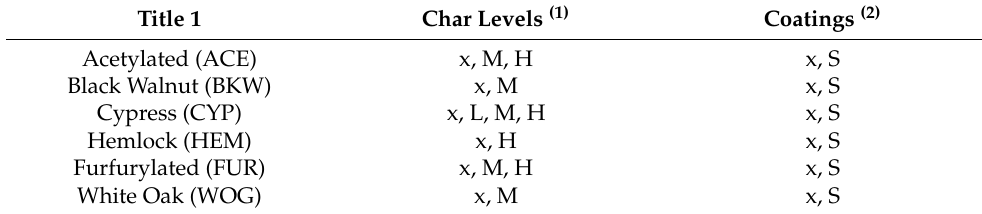
Figure 1. Surface images of the 31 specimens tested. Species group abbreviations are given in Table 1. Table 1. Summary of the species groups, char levels, and coatings tested.